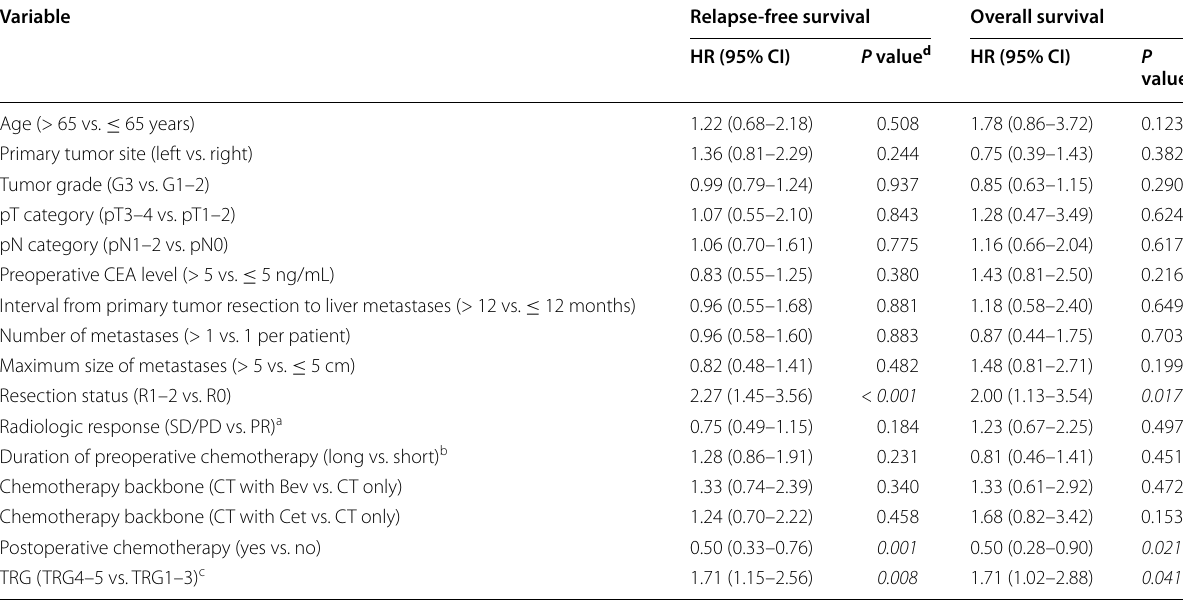
Table 3 Predictive factors for survival by multivariate Cox